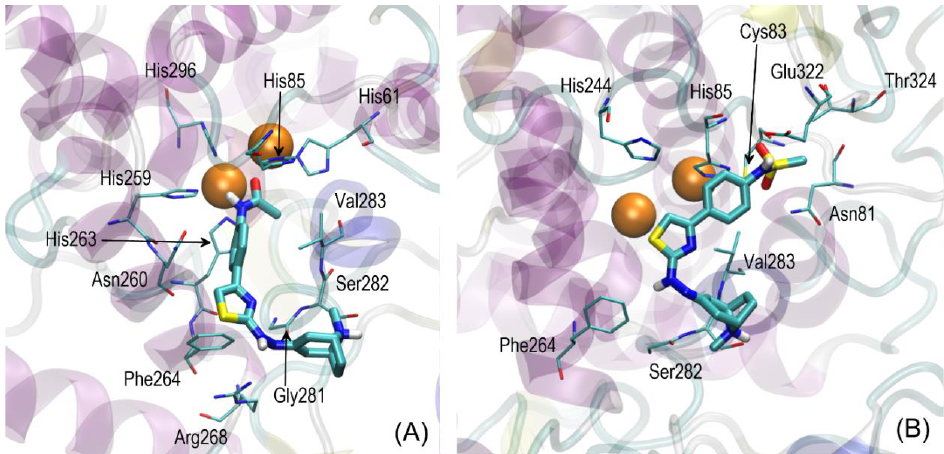
Figure 10. ( A ) The energetically-favorable location of the ligand molecule 3h bound to the 2y9x structure. ( B ) The alternative position of binding found only for the 3f ligand. The ligand molecules are shown as thick sticks whereas all the closest amino-acid residues are represented by thin sticks. Orange balls represent the copper ions, present in the protein crystal structure. The description of the interaction types is given in the text.